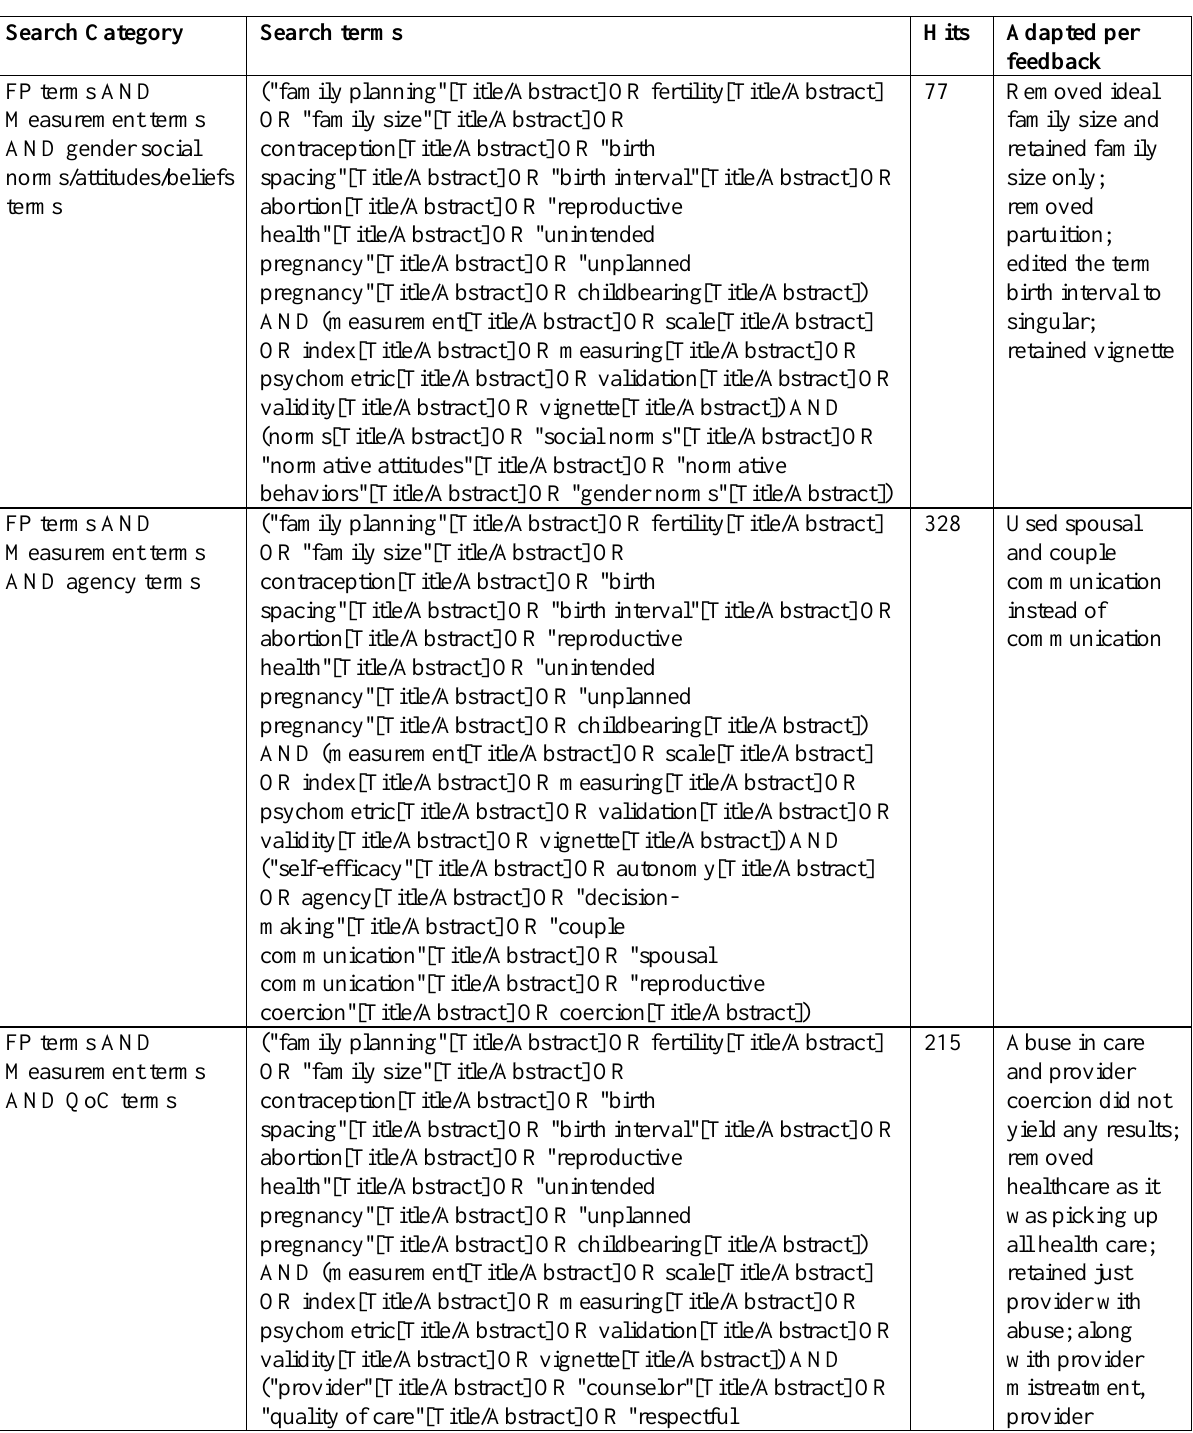
Table 4: List of search terms used as per category and feedback incorporated Search